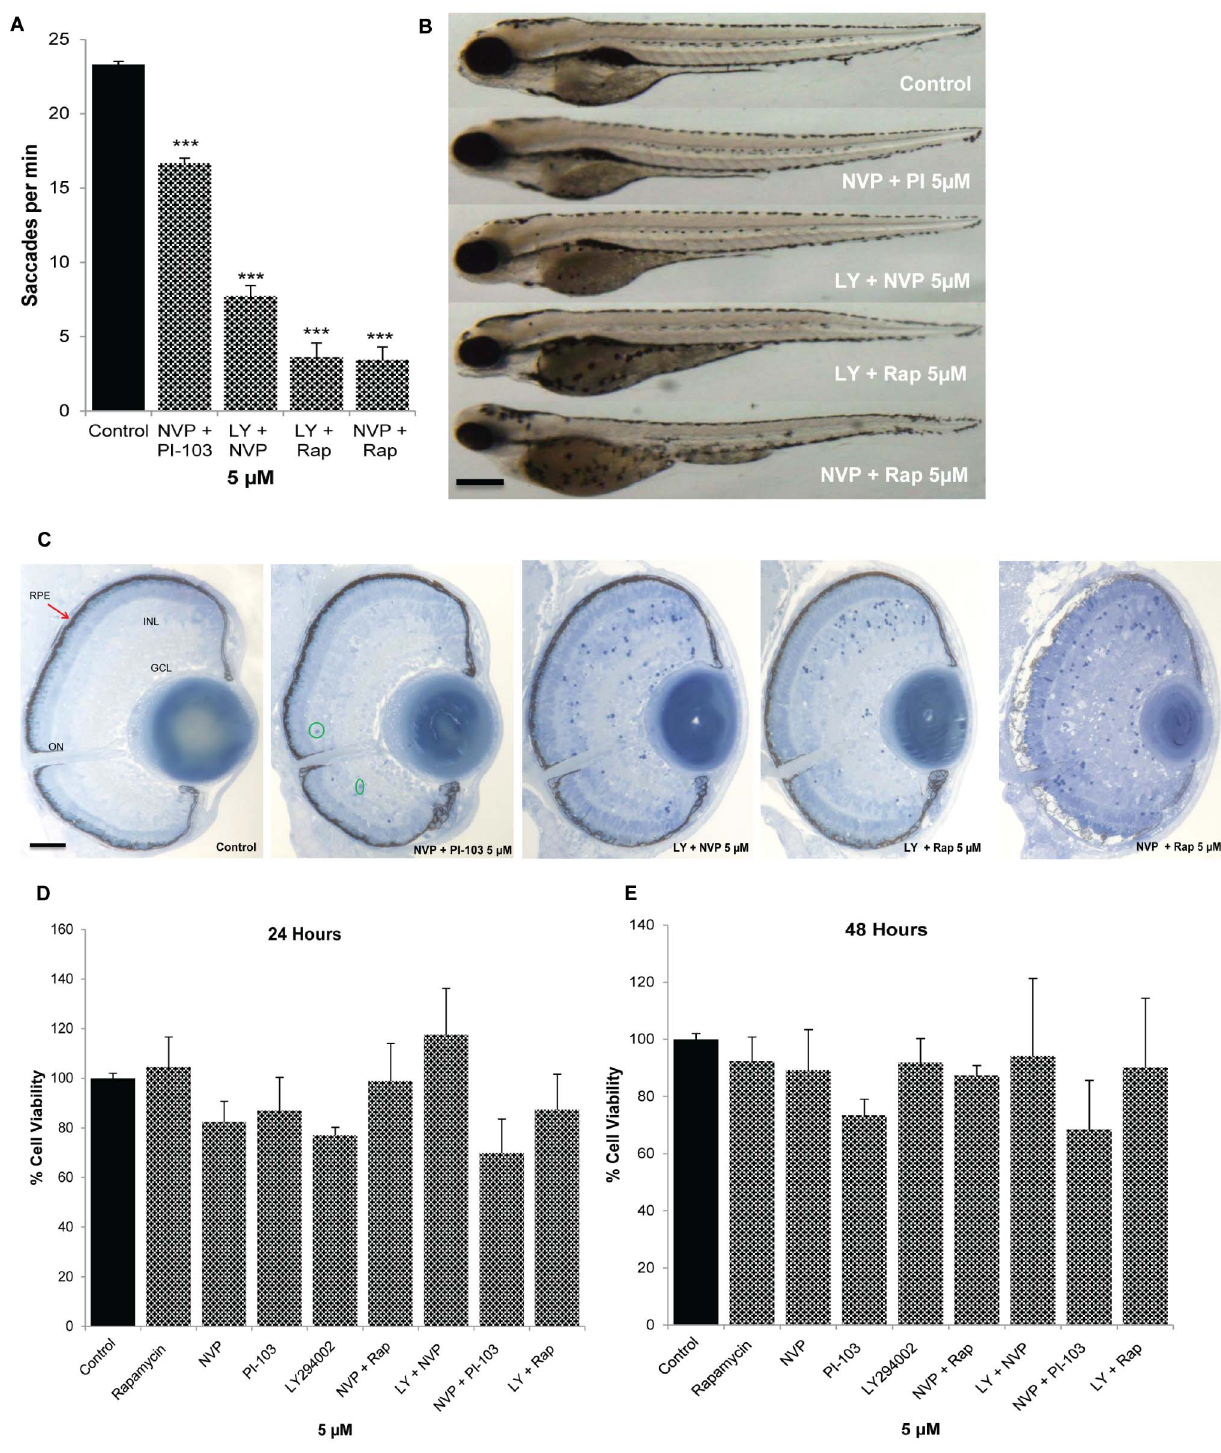
Figure 6. Safety pharmacology of PI3K/Akt/mTOR drug combinations in the zebrafish eye and human ARPE19 cells. 2 dpf larvae were treated with the most potent PI3K/Akt/mTOR inhibitors or control (0.1% DMSO) and eye saccades per minute quantified at 5 dpf ( A ). All PI3K/Akt/ mTOR inhibitors reduce the number of saccades per minute compared to control but 5 m M NVP-BEZ235 + PI-103 larvae have a largely intact OKR. Representative images of the gross morphology of treated larvae ( B ). The most potent drug combinations exhibited little to no effect on overall morphology except for 5 m M NVP-BEZ235 + PI-103 which resulted in reduced eye size. Representative light microscopy images of treated larval eyes ( C ). Histological analysis was conducted on 1 m m sections of PI3K/Akt/mTOR-treated larvae at 5 dpf with ten sections analyzed per treatment. Retinal morphology appeared as normal in 5 m M NVP-BEZ235 + PI-103 treated larvae, except for a small number of dying cells. Increased number of apoptotic cells was observed in 5 m M LY294002 + NVP-BEZ235 or 5 m M LY294002 + Rapamycin treated larvae. In particular, 5 m M NVP-BEZ235 + Rapamycin (5 m M) exert adverse effects on retinal lamination, RPE, lens and optic nerve integrity. Effects of PI3K/Akt/mTOR inhibitors on viability of